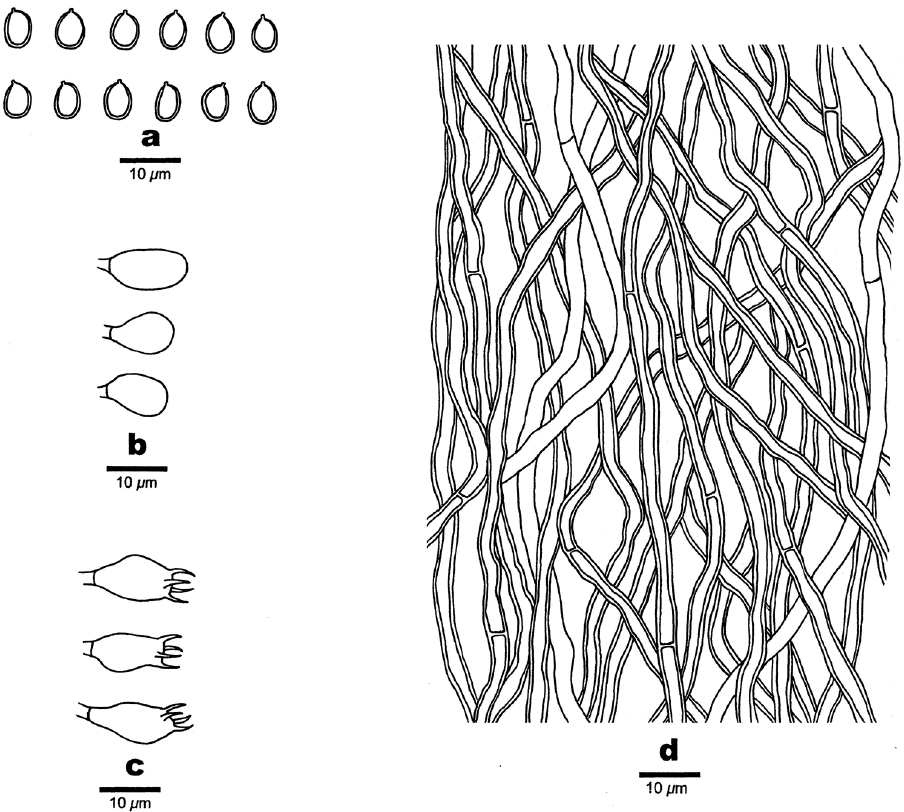
Figure 6. Microscopic structures of Fomitiporella mangrovei . a Basidiospores b Basidioles c Basidia d Hyphae from